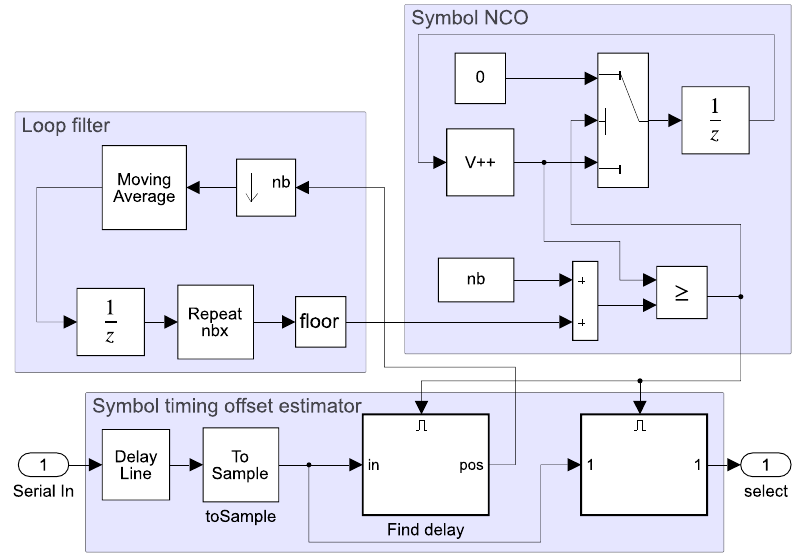
Figure 10. Implementation of the symbol timing (ST)